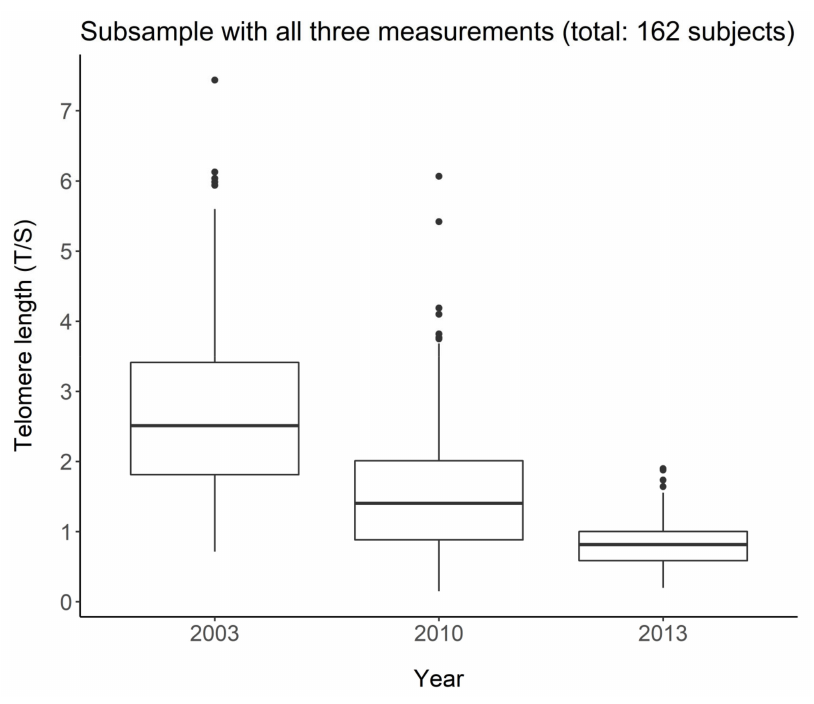
Figure 1. Telomere length change over the three waves in the group of 162 subjects with all three measurements.